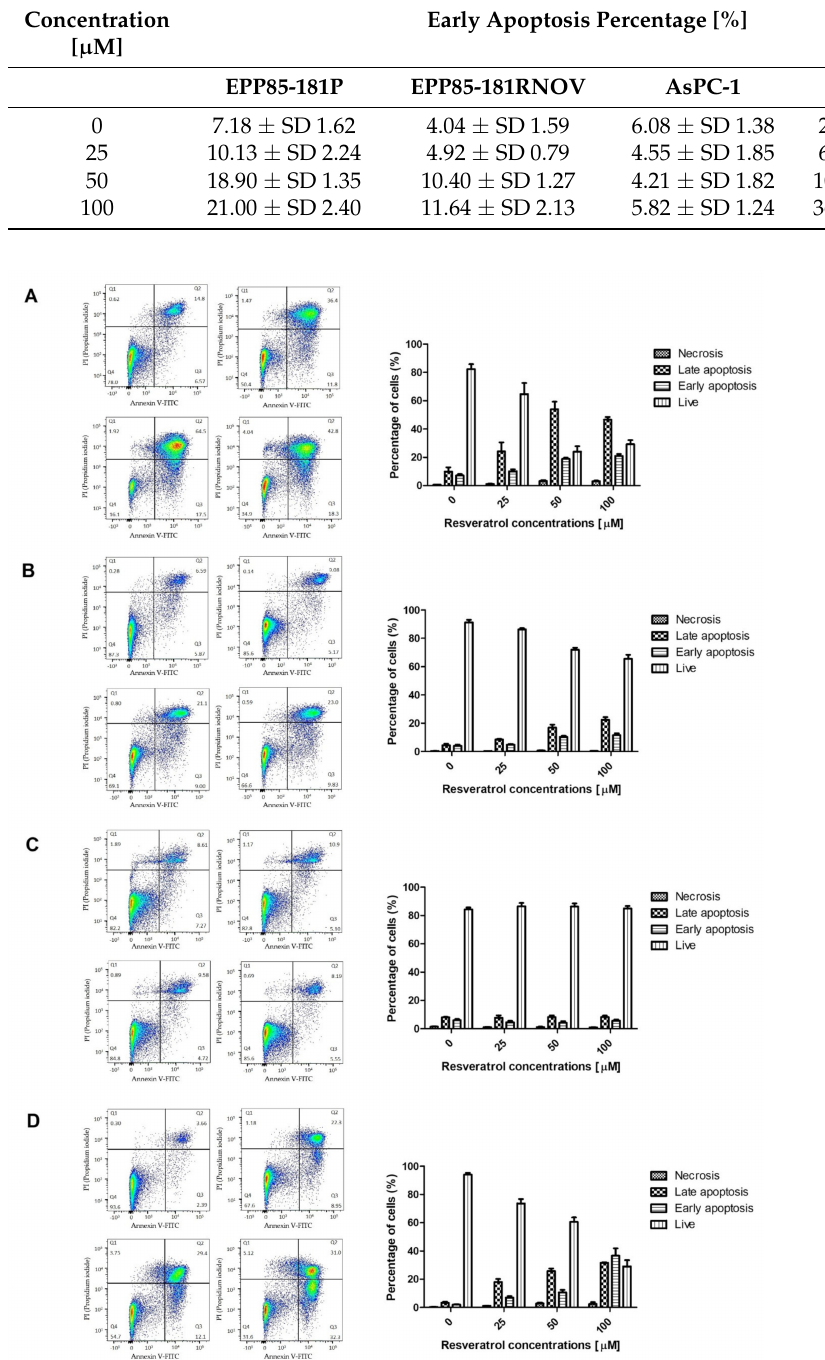
Figure 4. Analysis of apoptotic cells after incubation with resveratrol using flow cytometry. ( A ) EPP85-181P cell line, ( B ) EPP85-181RNOV cell line, ( C ) AsPC-1 cell line and ( D ) H6c7 cell